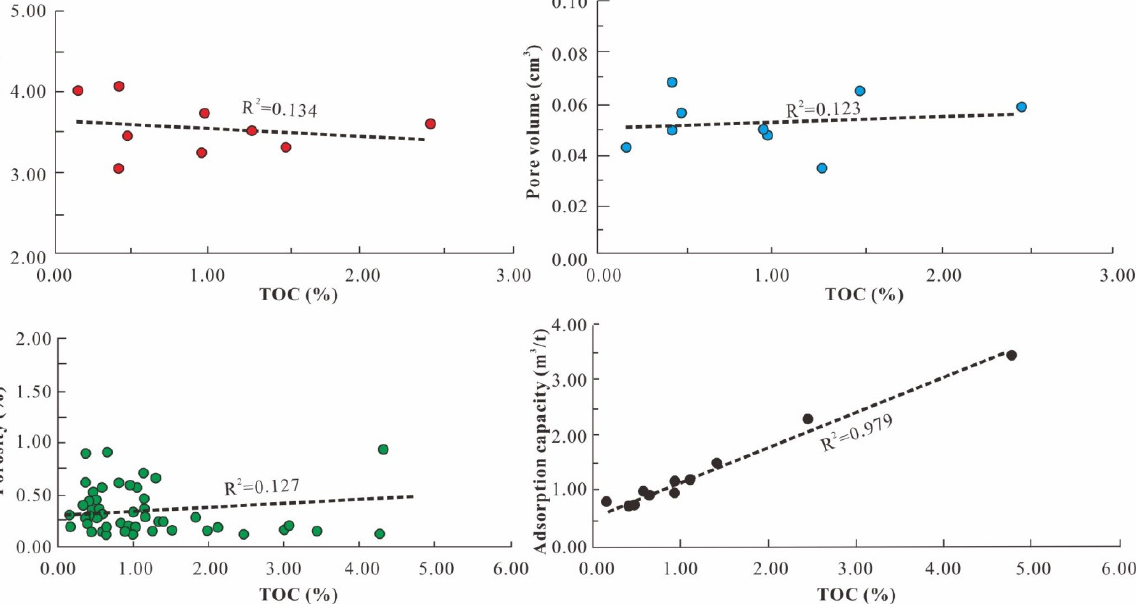
Figure 10. Relationship between TOC and reservoir physical parameters.